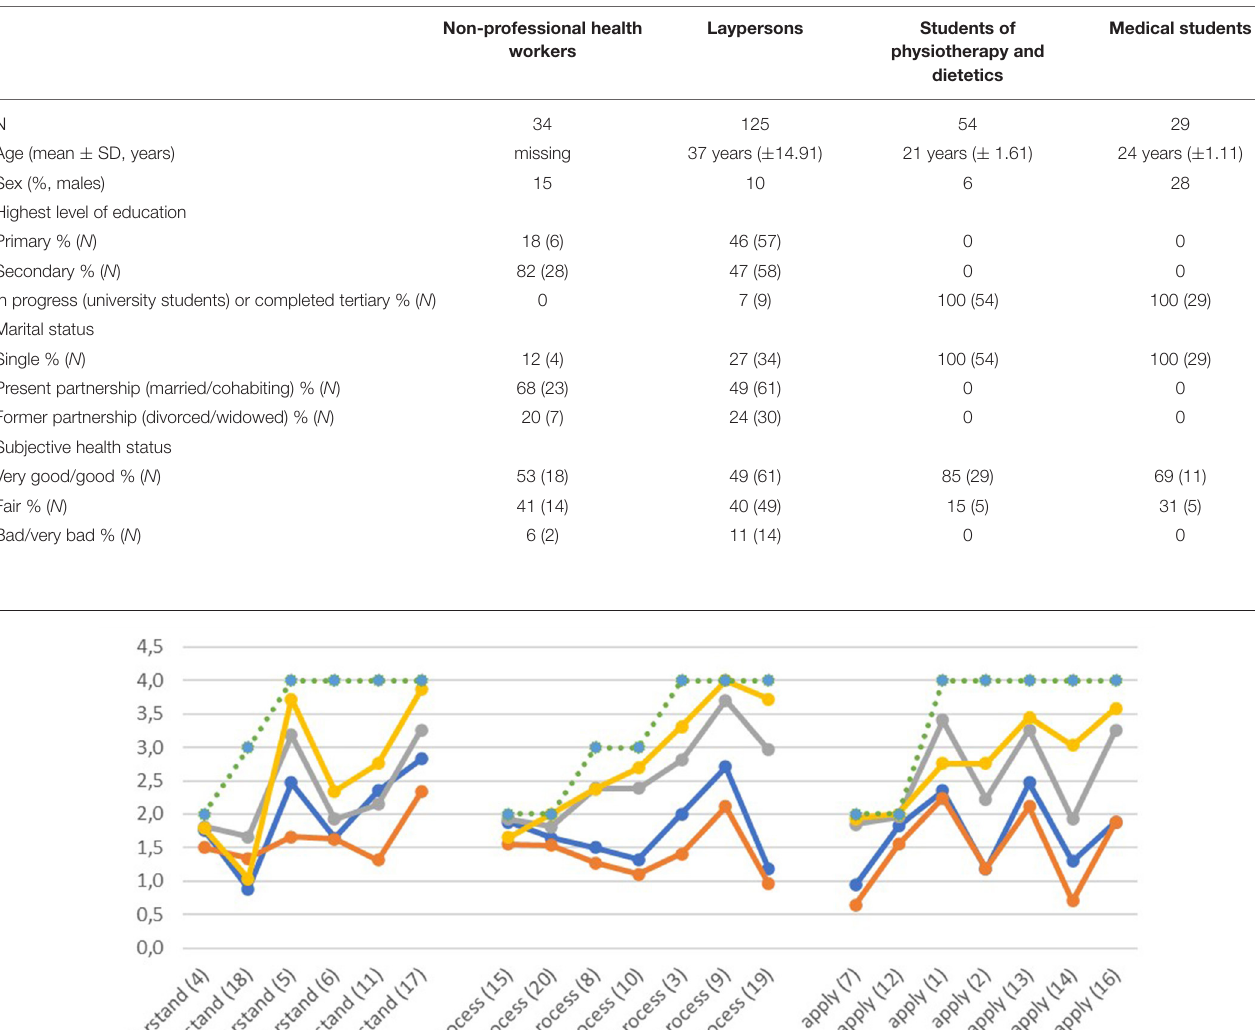
TABLE 2 | Features of the participants by occupational/study group.